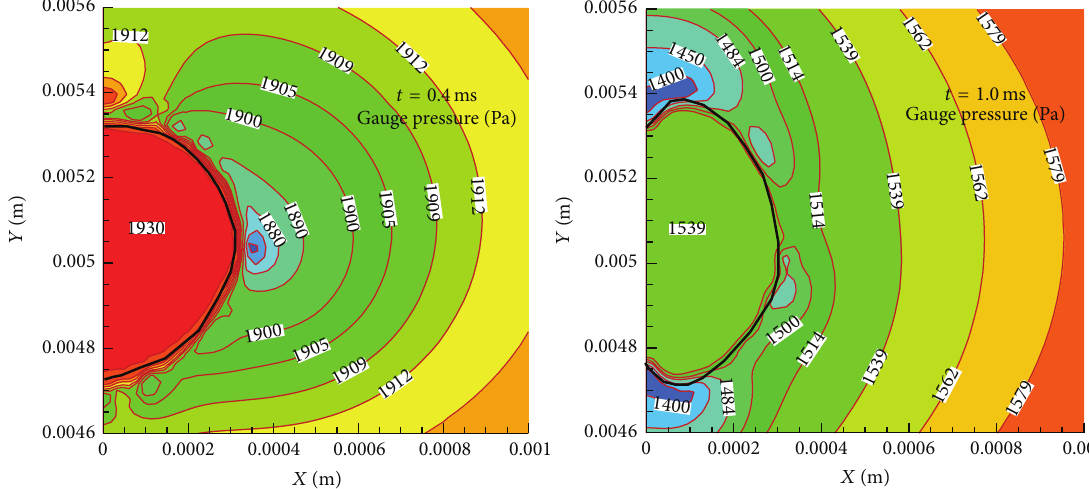
Figure 7: The pressure field distribution of bubble growth at 𝑡 = 0.4 ms and 𝑡 = 1.0 ms on case 1 .